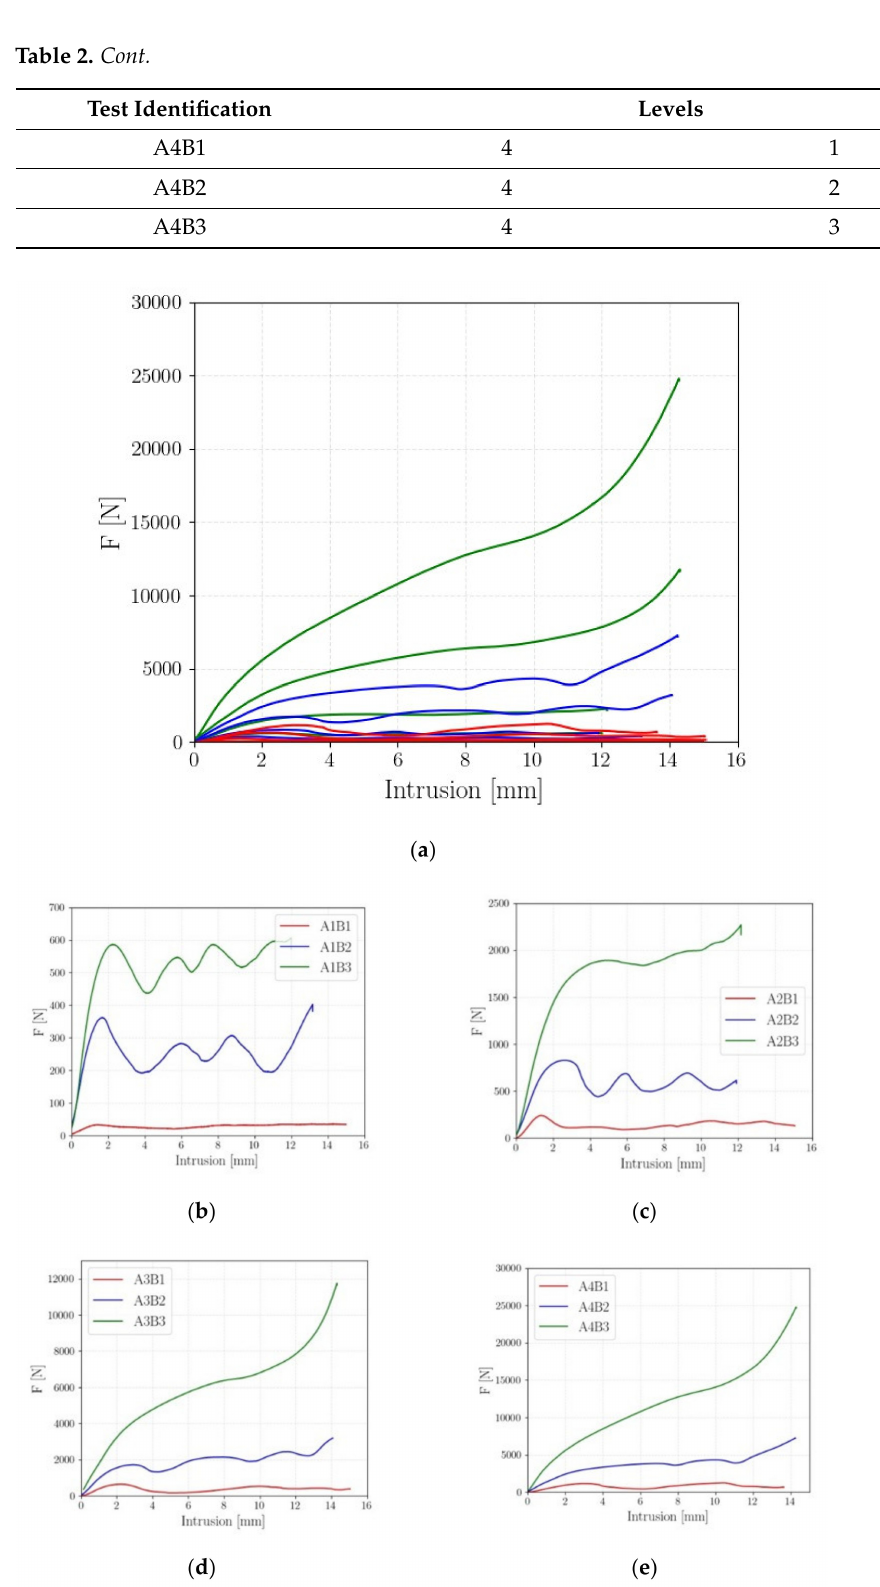
Figure 5. Experimental force–displacement curves for FP1 : ( a ) one representative curve for each specimen condition; ( b ) force–displacement curves for d = 0.9 mm; ( c ) force–displacement curves for d = 1.2 mm; ( d ) force–displacement curves for d = 1.5 mm; ( e ) force–displacement curves for d = 1.8